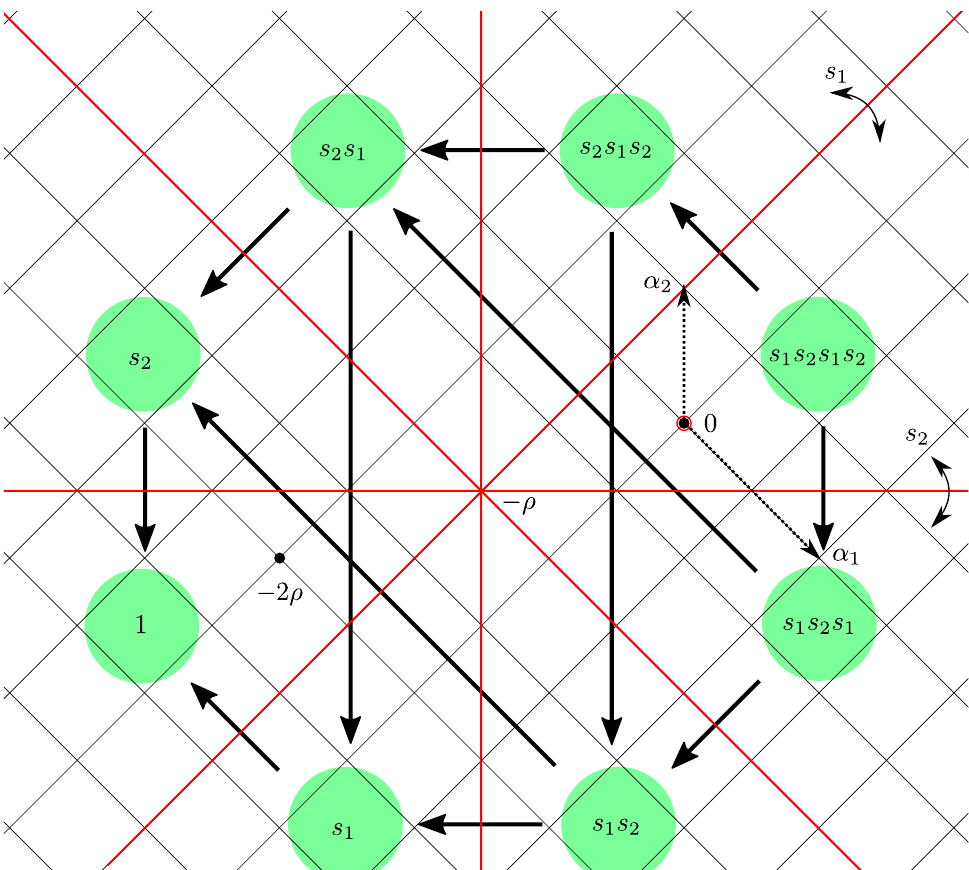
Figure 1 . The B 2 (shifted) Weyl chambers, their associated Weyl group element in terms of simple re(cid:13)ections s i , their Bruhat order, the simple roots (cid:11) i and the integral weight lattice. The red lines correspond to singular weights, and delimitate the shifted Weyl chambers. The intersections of gray lines correspond to integral